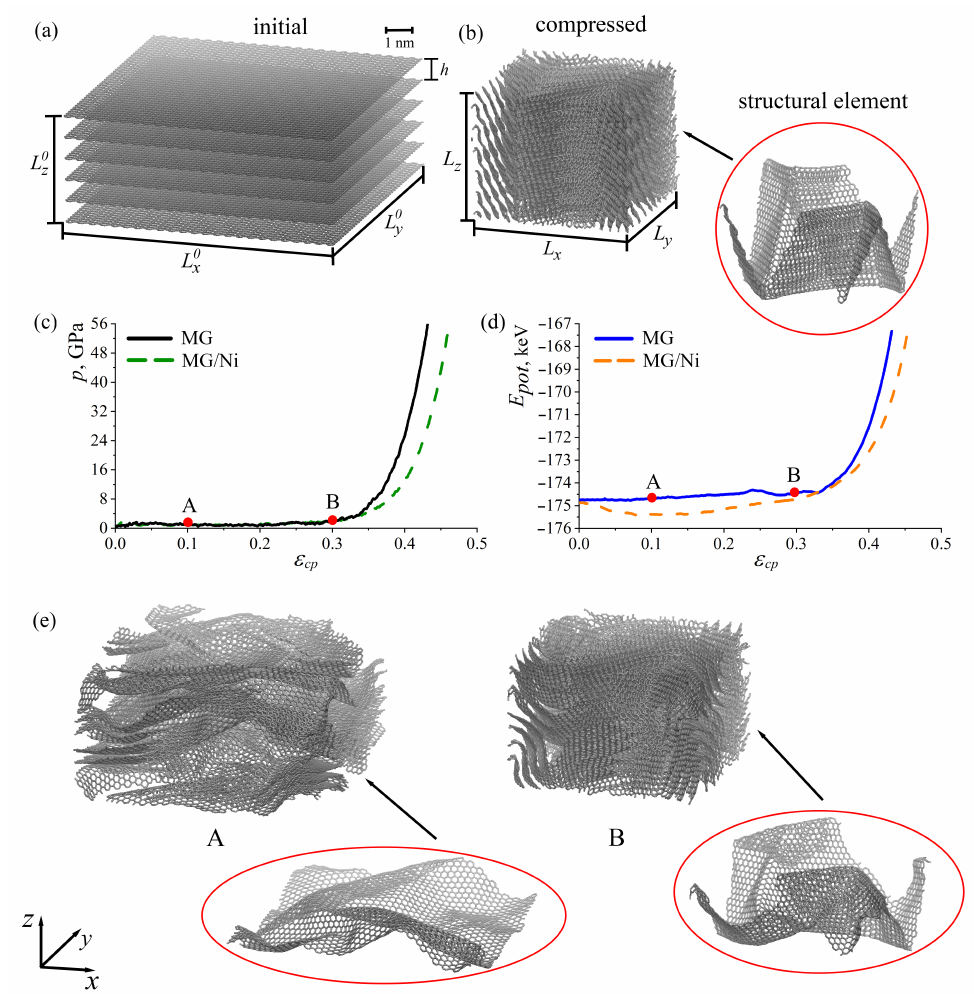
Figure 1. ( a ) Initial structure of multilayer graphene (MG). ( b ) Structure of MG after compression. ( c ) Pressure–strain ( c ) and potential energy–strain ( d ) curves during compression for MG and MG with Ni nanoparticles between layers. ( e ) The snapshots of structure at points: ε cp = 0.01 ( A ) and ε cp = 0.03 ( B